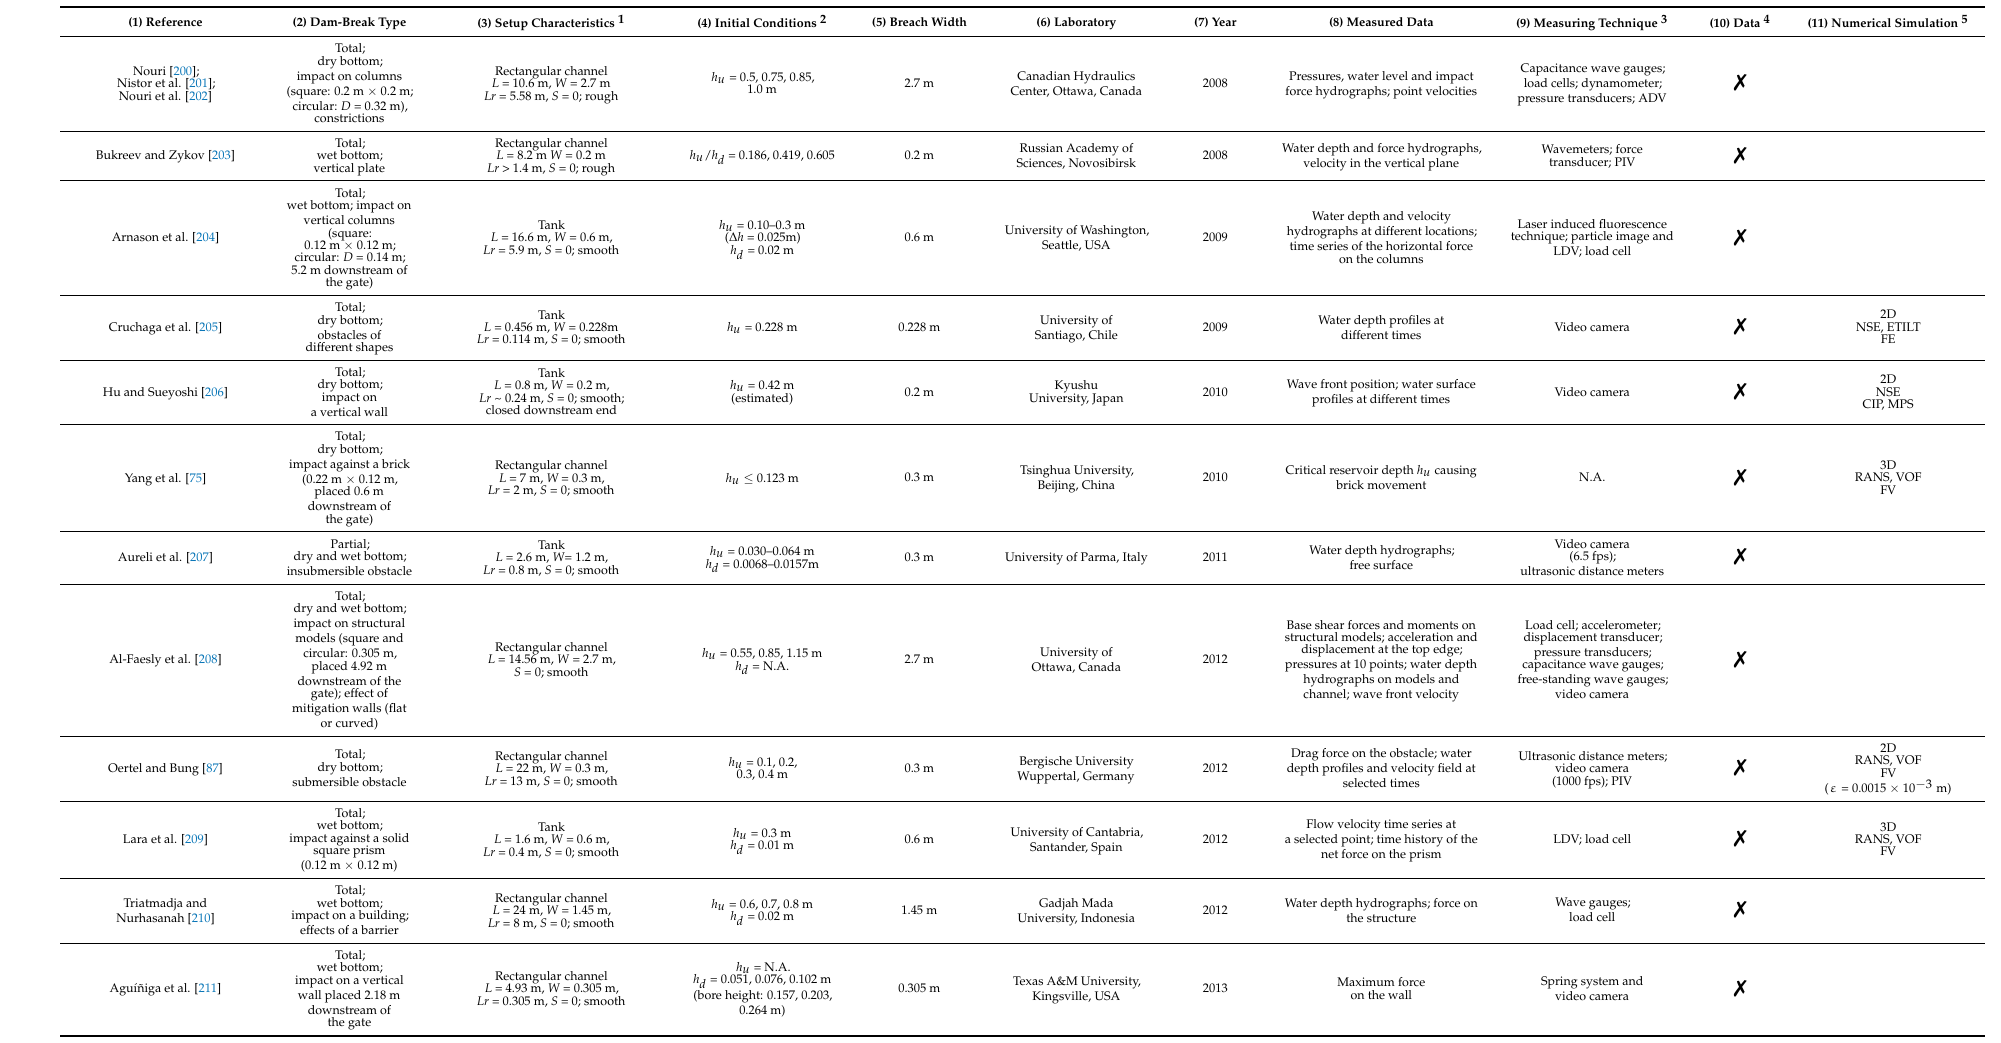
Table 1. Basic experimental investigations of fundamental dam-break wave physical characteristics.